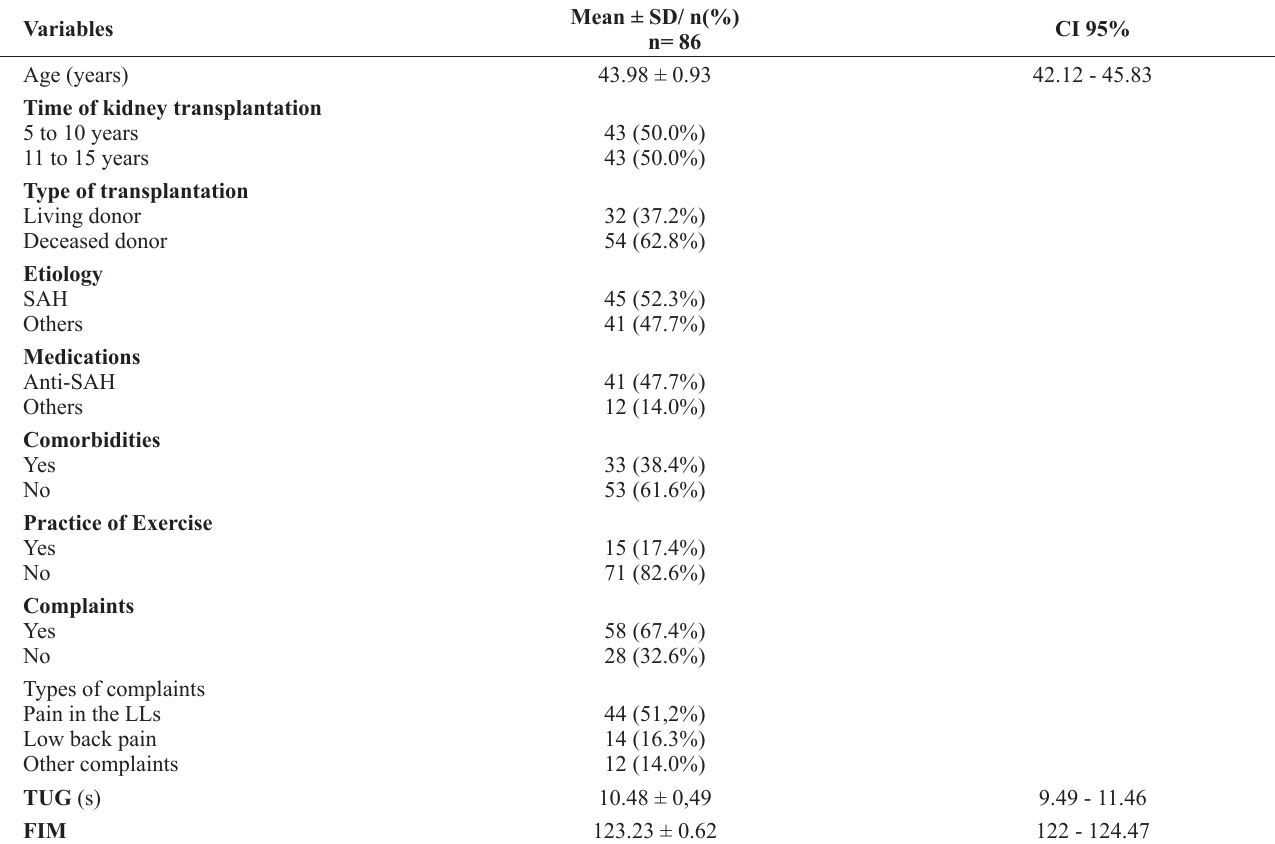
Table 1. General characteristics of kidney transplant patients from the Nephrology Service, Hospital das Clínicas UFPE, Recife, Brazil. Variables